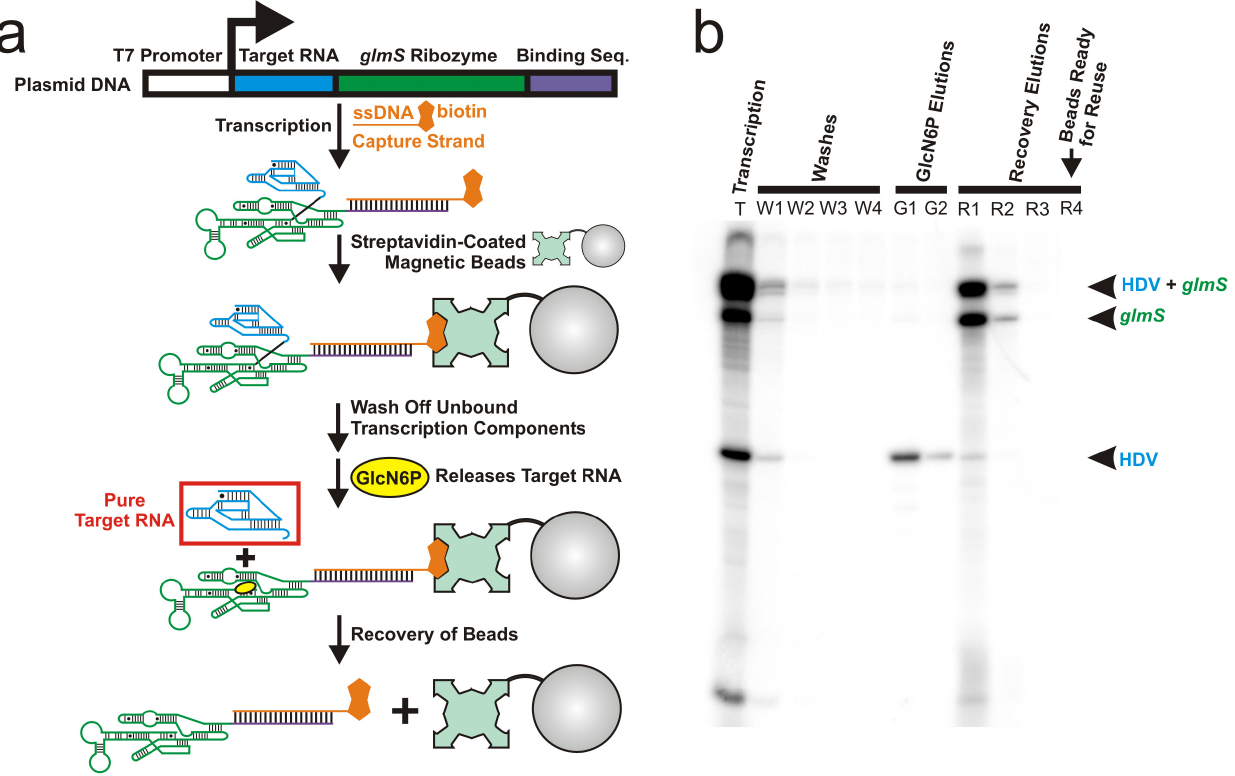
Figure 1. Native purification strategy and results. ( a ) Diagram of the strategy used to purify natively folded RNA. ( b ) Supernatants collected at various steps of the protocol and analyzed by denaturing, 8 M urea, 10% PAGE. ‘‘HDV’’ refers to the targeted self-cleaved HDV ribozyme, ‘‘ glmS ’’ to the self-cleaved glmS ribozyme with attached binding sequence, and ‘‘HDV + glmS ’’ to the transcript containing the HDV ribozyme with attached uncleaved glmS ribozyme and binding sequence.